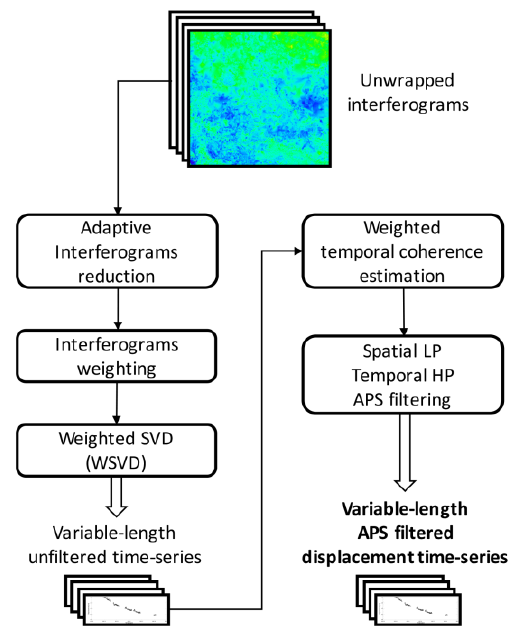
Figure 6. Flow chart of the WAVE algorithm.